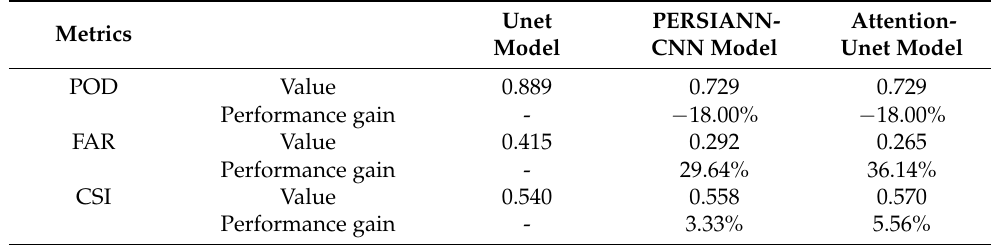
Table 10. Summary of precipitation identification performances over extreme precipitation events.